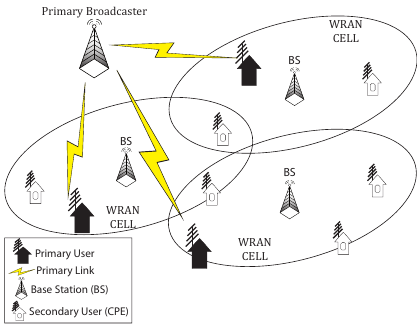
Figure 1. The IEEE 802.22 network architecture. WRAN, wireless regional area network; CPE,